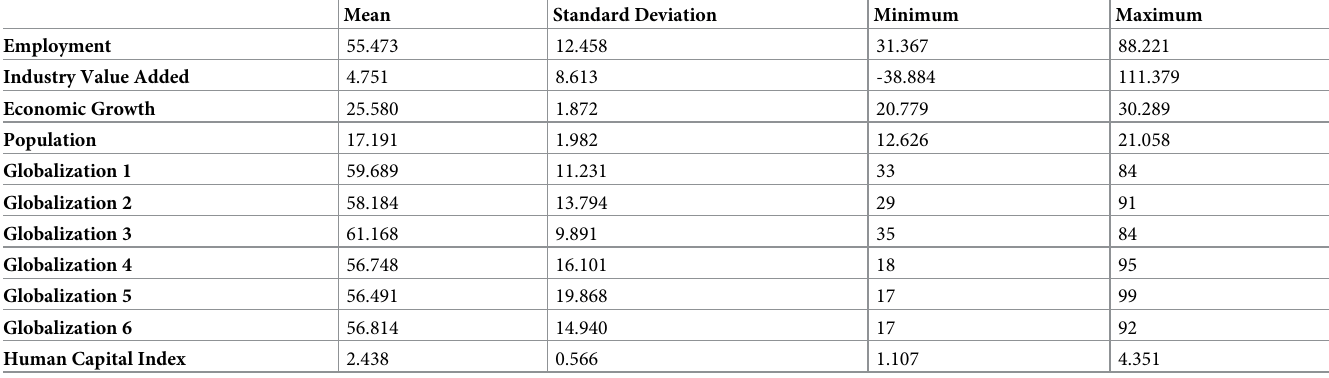
Table 1. Descriptive